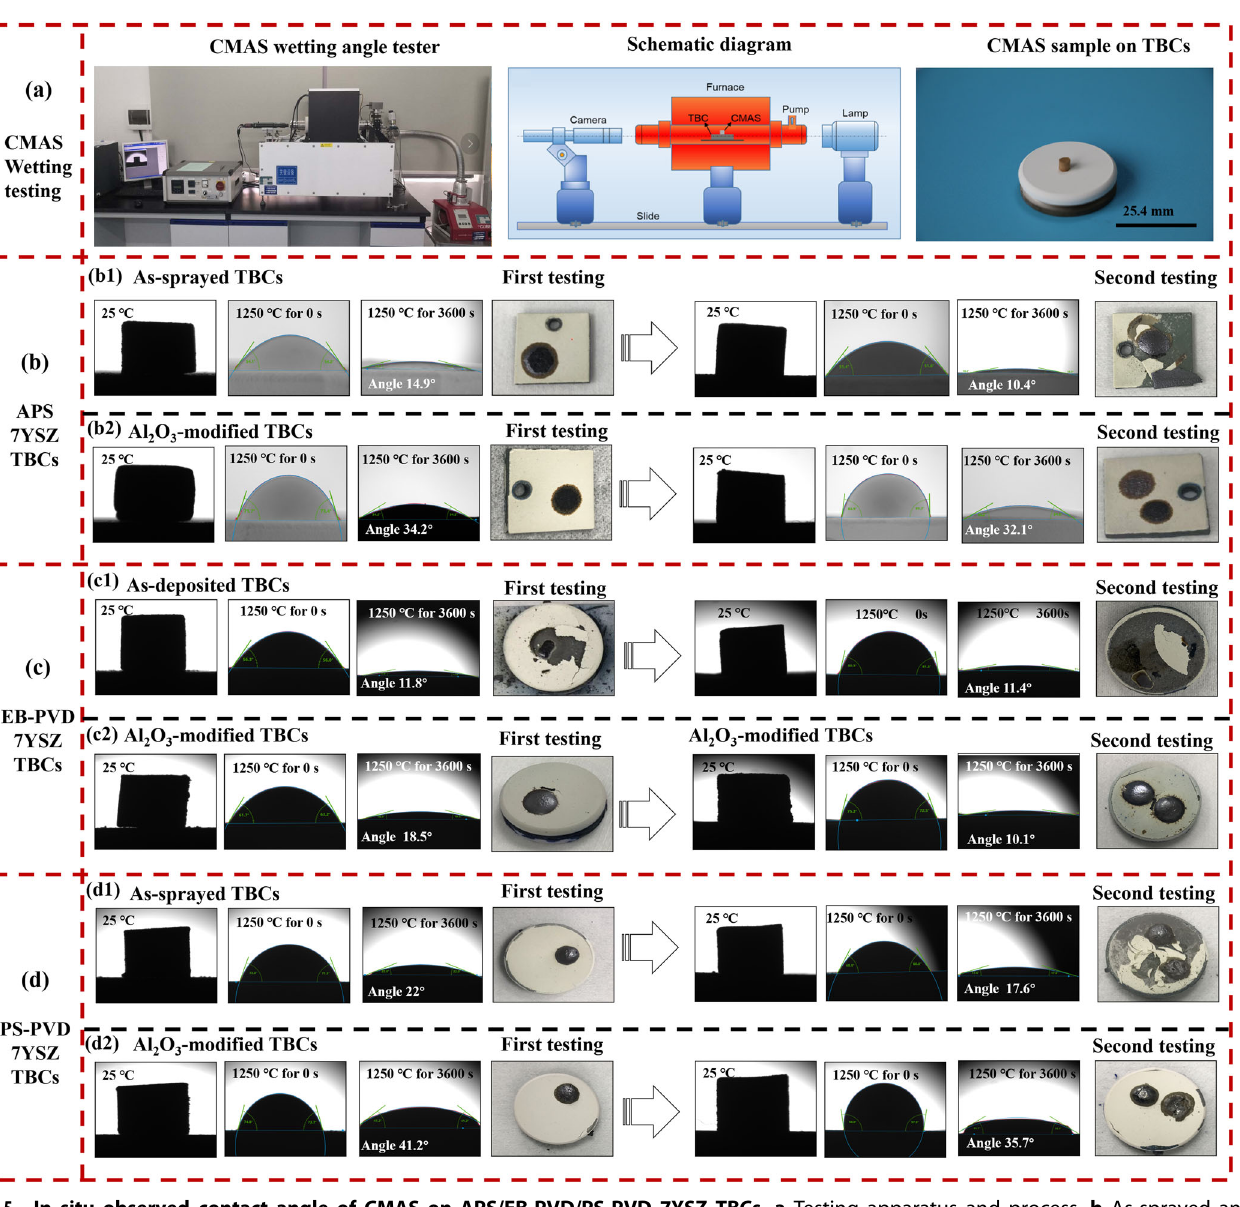
Fig. 5 In situ observed contact angle of CMAS on APS/EB-PVD/PS-PVD 7YSZ TBCs. a Testing apparatus and process. b As-sprayed and Al 2 O 3 -modi fi ed APS 7YSZ TBCs. c As-deposited and Al 2 O 3 -modi fi ed EB-PVD 7YSZ TBCs. d As-sprayed and Al 2 O 3 -modi fi ed PS-PVD 7YSZ